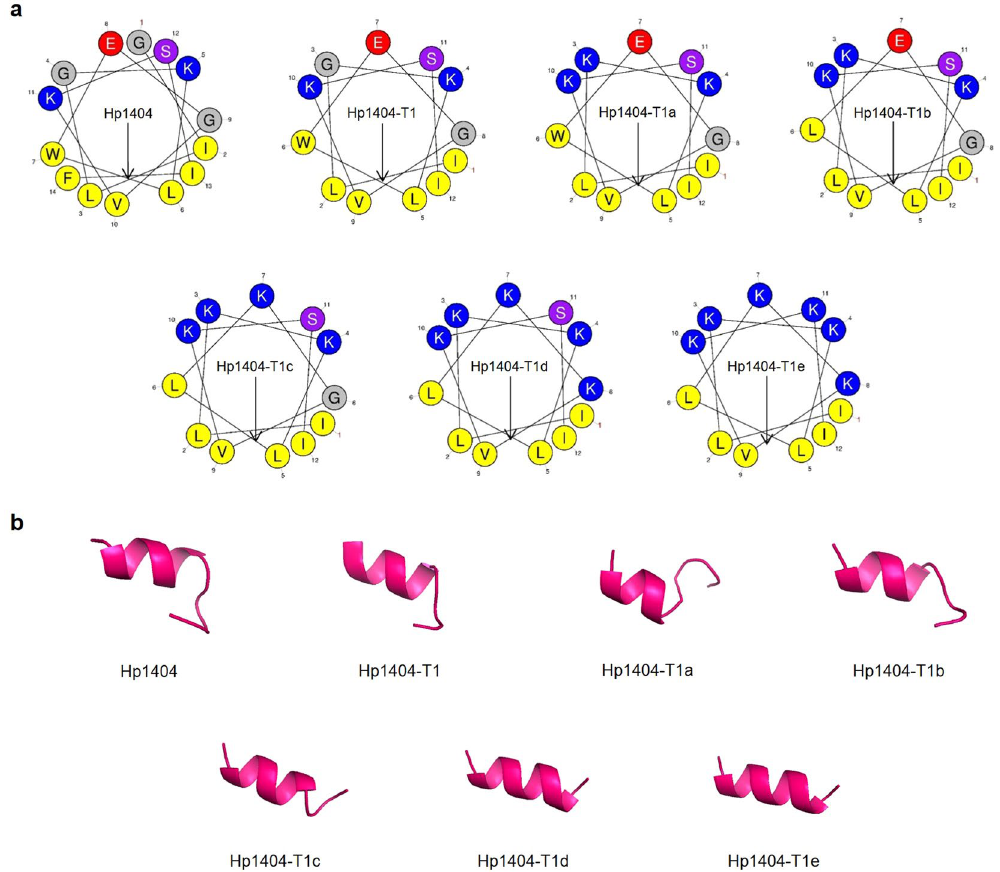
Figure 1. Structural analyses of Hp1404 and its analogue peptides. ( a ) Helical wheel projection of Hp1404 and its analogue peptides. The HeliQuest site and the Mobyle@RPBS portal were used for the construction of diagrams and projections, respectively. The hydrophobic residues are represented in yellow, negatively charged residues are red, positively charged residues are blue, and the particular polar residue is violet. The arrows represent the helical hydrophobic moment. ( b ) Three-dimensional structure simulations of the peptides are depicted in the ribbon